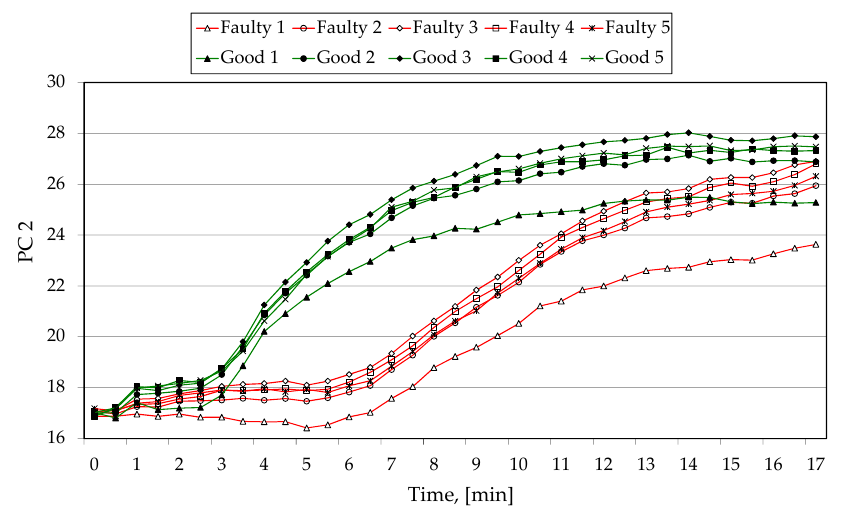
Figure 5. Time dependence of the second principal component (PC2) of thermal images (10 devices).